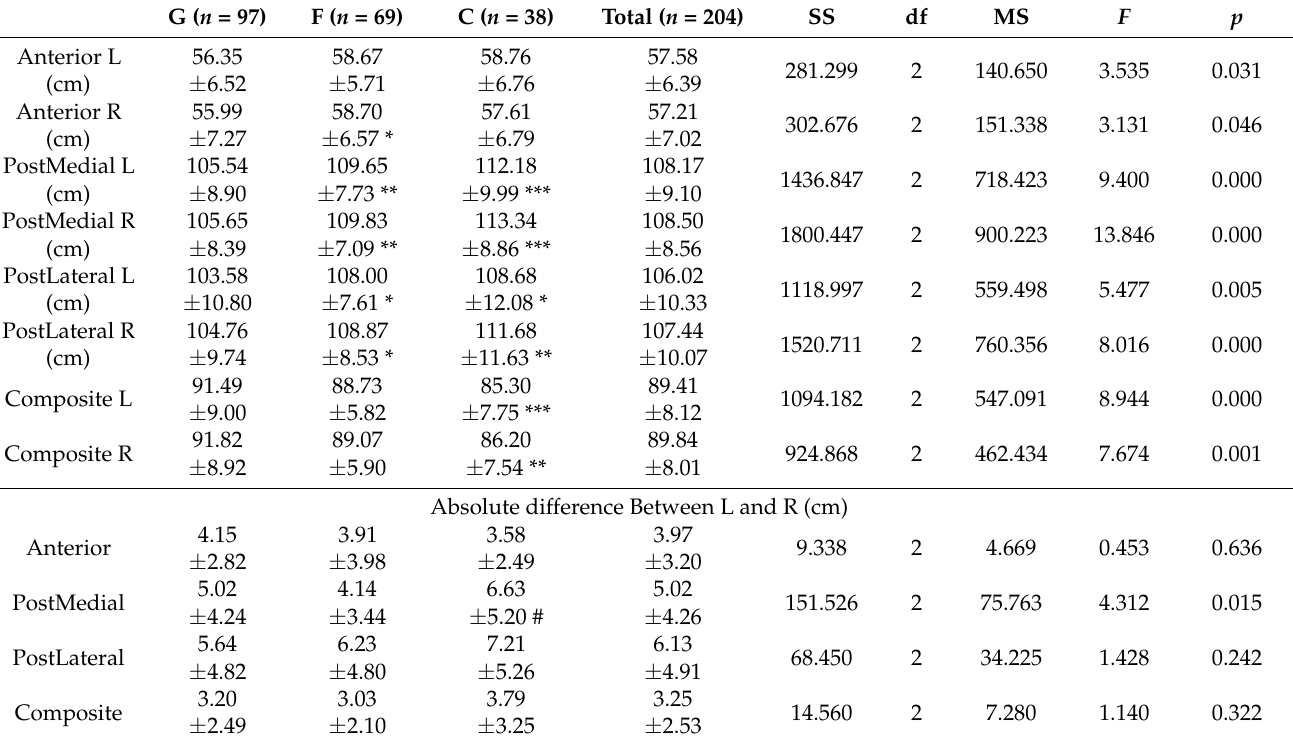
Table 4. Differences in lower extremity stability according to the play